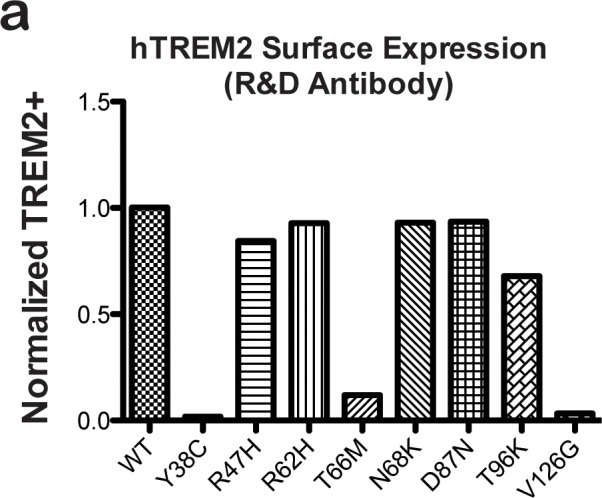
hTREM2 surface expression probed using a commercial antibody.(a) hTREM2 surface expression was probed by flow cytometry using a commercial anti-TREM2 antibody (R&D). The results are comparable to results obtained using our anti-TREM2 polysera (see Figure 2d). In this experiment, anti-FLAG staining was observed for all variants as in Figure 2e (not shown).